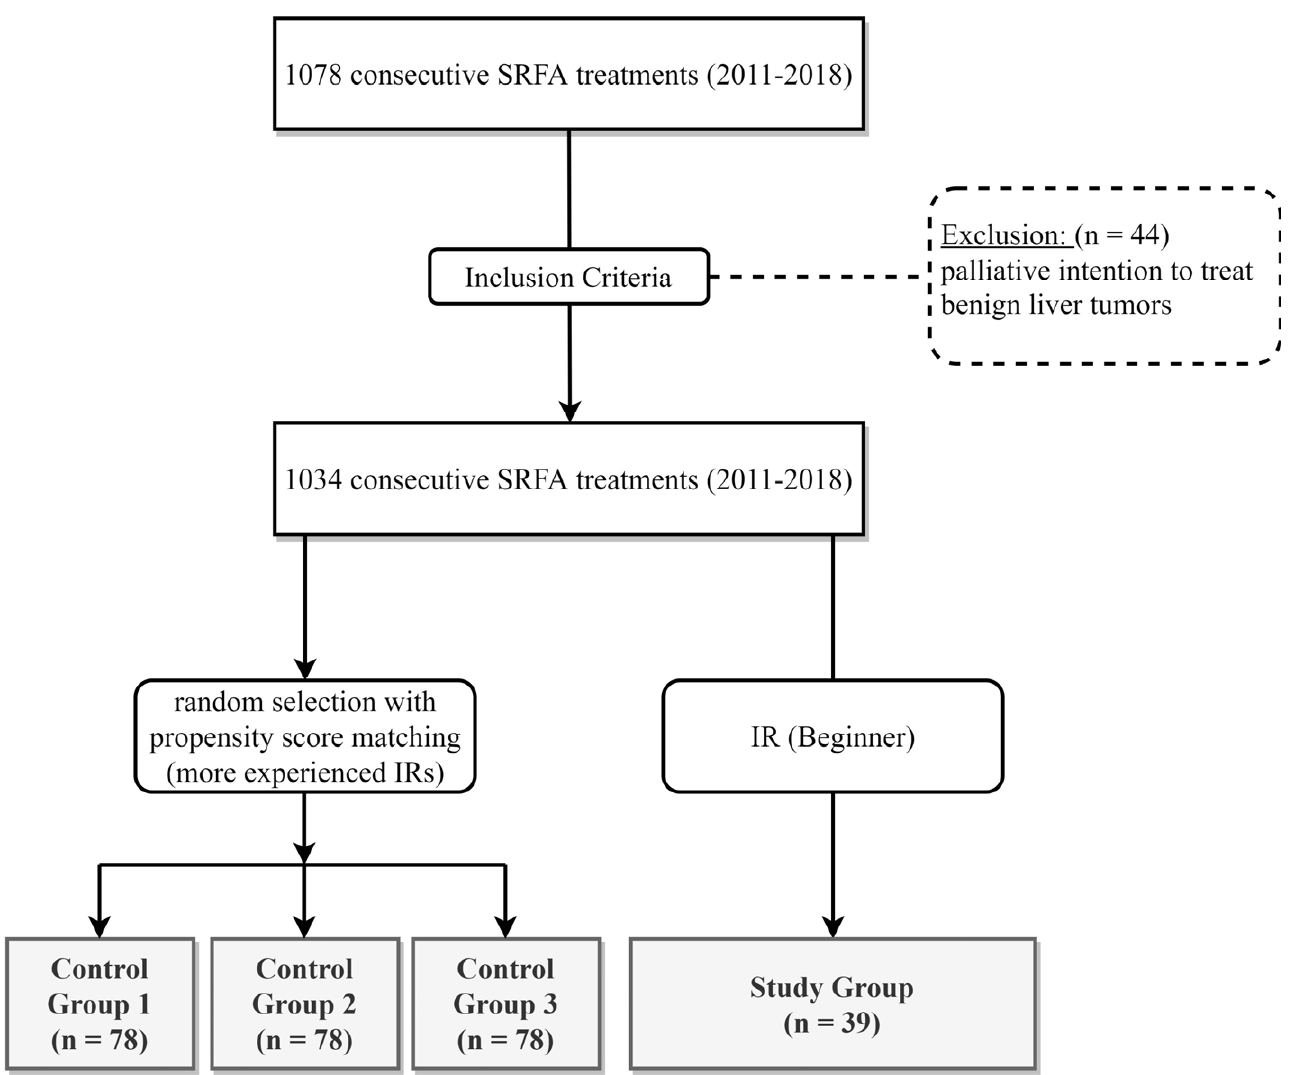
Figure 1. Flowchart of group assignment. IR = interventional radiologist. Exclusion criteria for SRFA were a prothrombin activity <50%, platelet count of <50,000/mm 3 , and tumor location within 1 cm of the central bile duct. Tumor